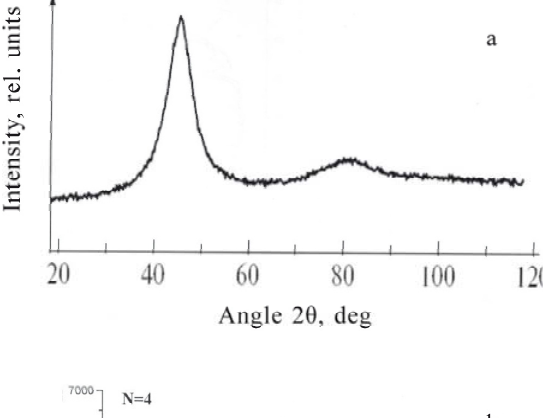
Fig. 7. X-ray diffraction diagrams of the Ni Fe Co Si B amorphous alloy in the initial con- 44 29 15 2 10 dition after melt quenching (a), after n = 4 at 293K and 77K (b) and after n = 8 at the same deformation temperature (c).